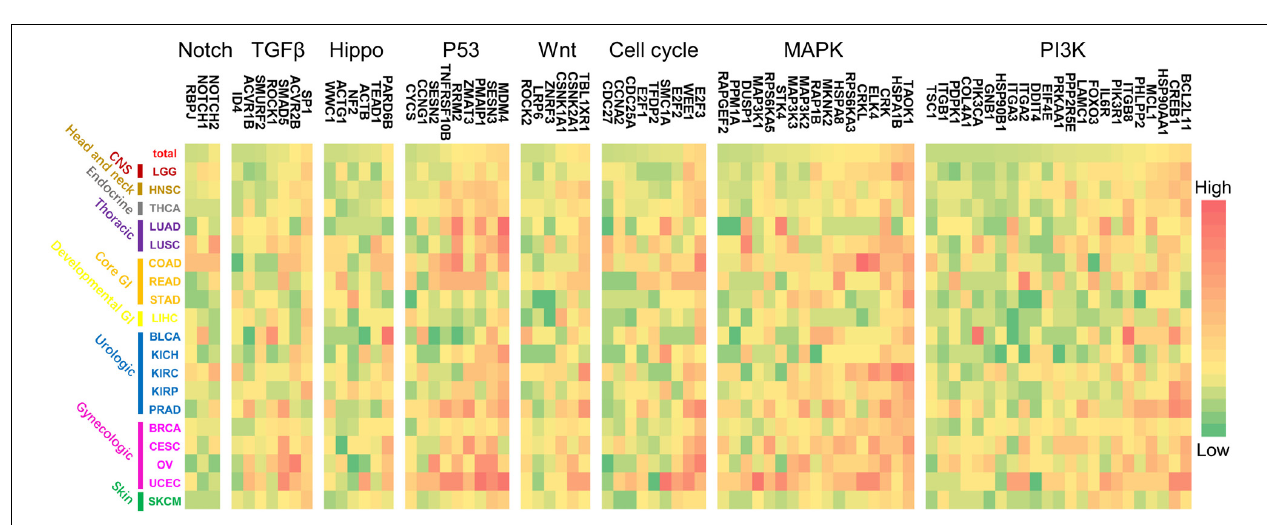
FIGURE 5 | Pan-cancer regulation of miRNA markers in canonical pathways. The X-axis represents eight different essential canonical pathways including PI3K, MAPK, Cell cycle, Wnt, P53, Hippo, TGF β , and Notch. Y-axis represents 19 cancer types and corresponding cancer categories. Different numbers and colors represent the regulation percentage of corresponding miRNA markers.